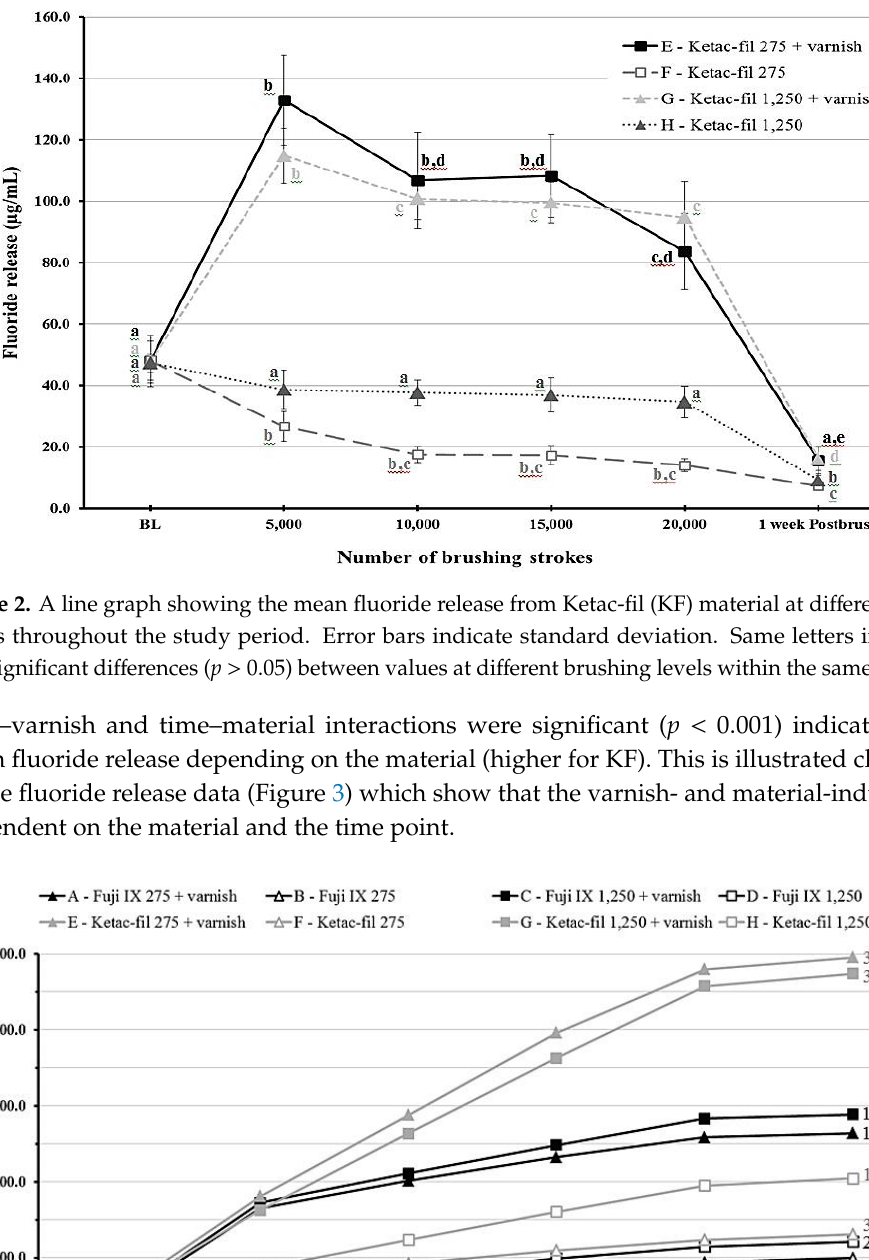
Figure 3. A line graph showing cumulative fluoride release from the experimental groups at different time points throughout the study period. Values on the right indicate percentage increases in cumulative fluoride release compared to group B.